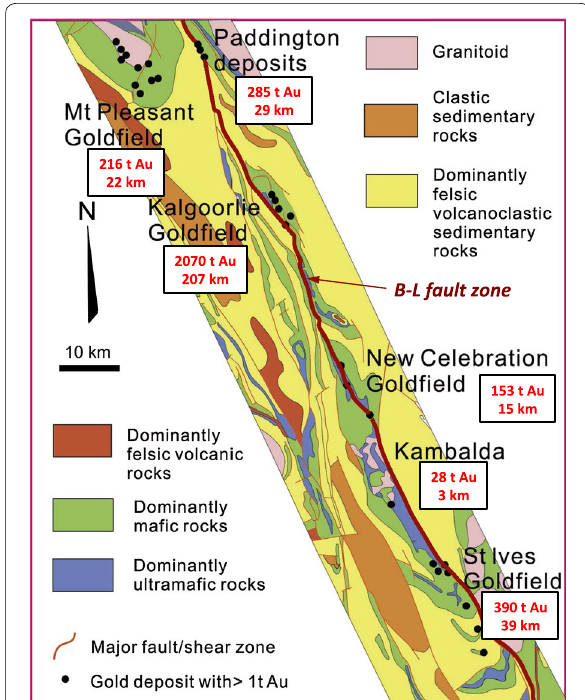
Fig. 6 Irregular distribution of major orogenic Au–quartz vein systems (> 1 tonne Au production) along the Boulder–Lefroy fault zone (B–L fault zone) transecting the Archean Yilgarn Craton of Western Australia (after Groves et al. 2018). Listed in the boxes associated with each goldfield are estimates of the total Au-endowment for each field (top) from Guj et al. (2011) (based on a compilation from Barrick Gold), and the equivalent heights of 1 km 2 columns of mineralizing fluid responsible for each field (bottom) assuming a